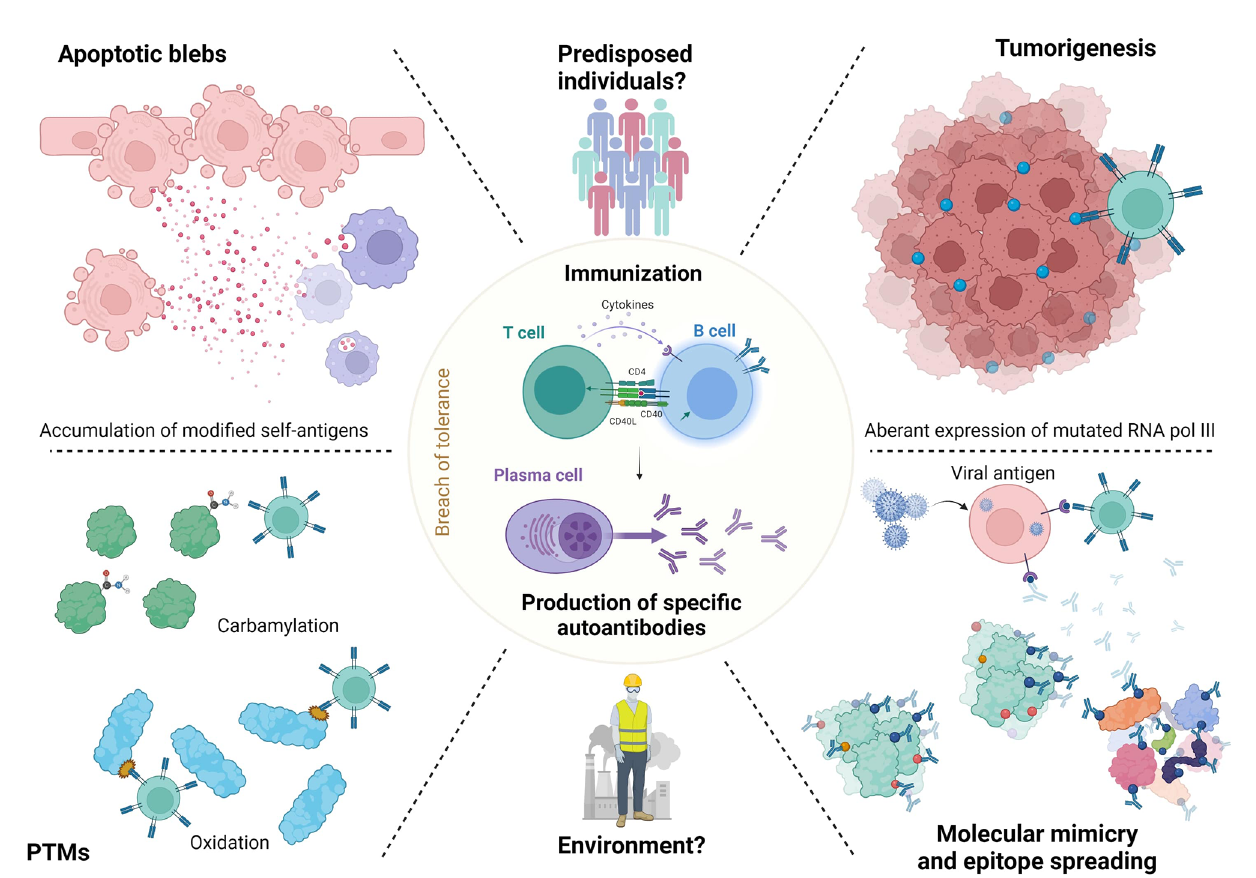
FIGURE 2 | ANA generation in SSc. Release of neoantigens could lead in predisposed individuals to immunization and antibodies generation. These neoantigens may raise from apoptotic blebs. Their release could be favorized by environmental factors like silica or solvents. Neoantigens can undergo post-translational modi fi cation (PTM) or modi fi cations by tumorigenesis (RNA polymerase 3). Then, epitope spreading mechanisms lead to immunization to both modi fi ed or normal antigens, which generate antibodies. Finally, molecular mimicry mechanisms with viral agents like Epstein Barr virus are also